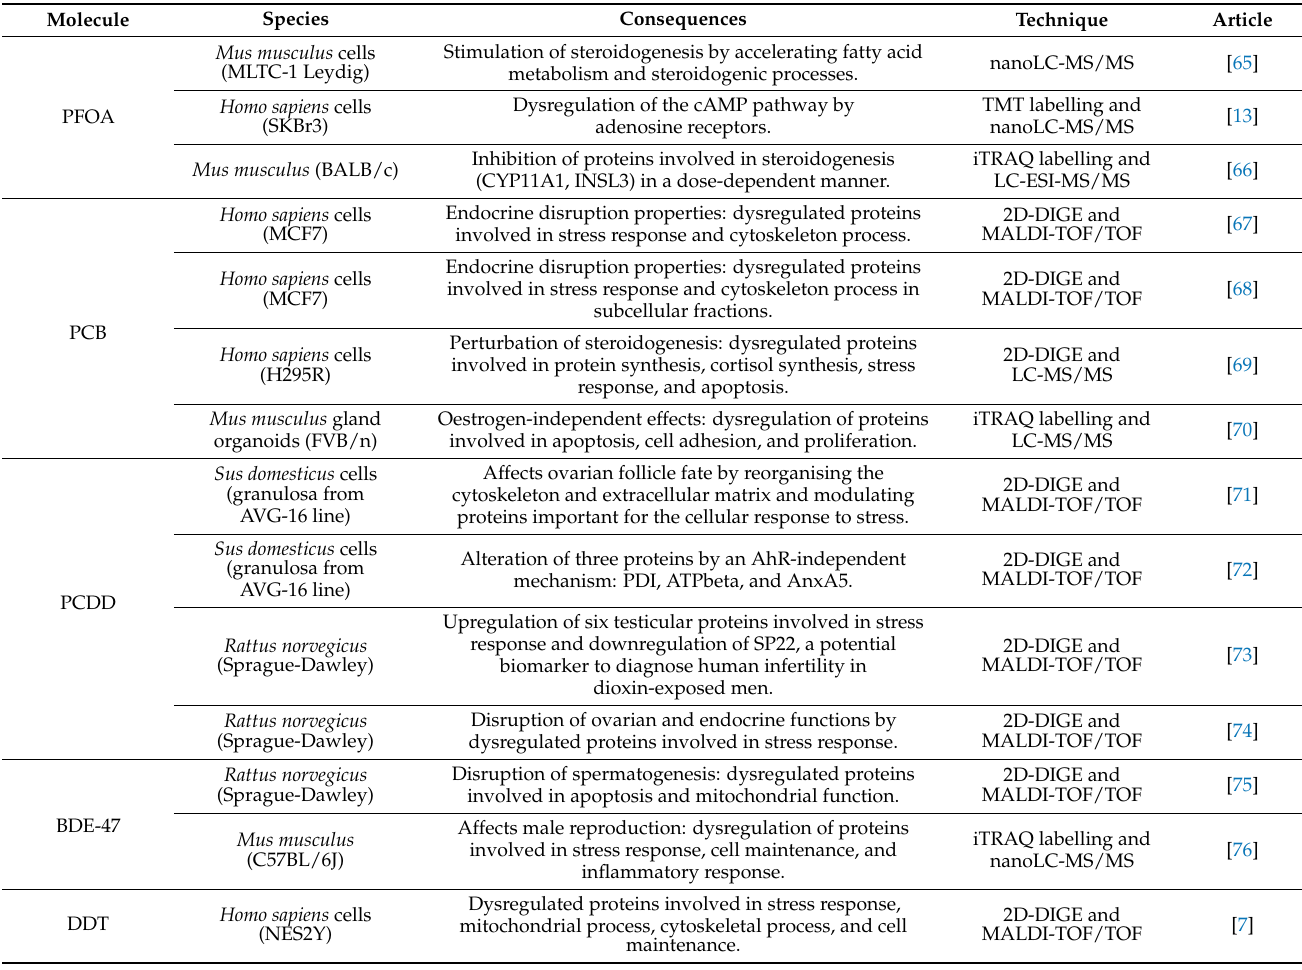
Table 3. Articles describing POP-induced reprotoxicity and endocrine disruption.